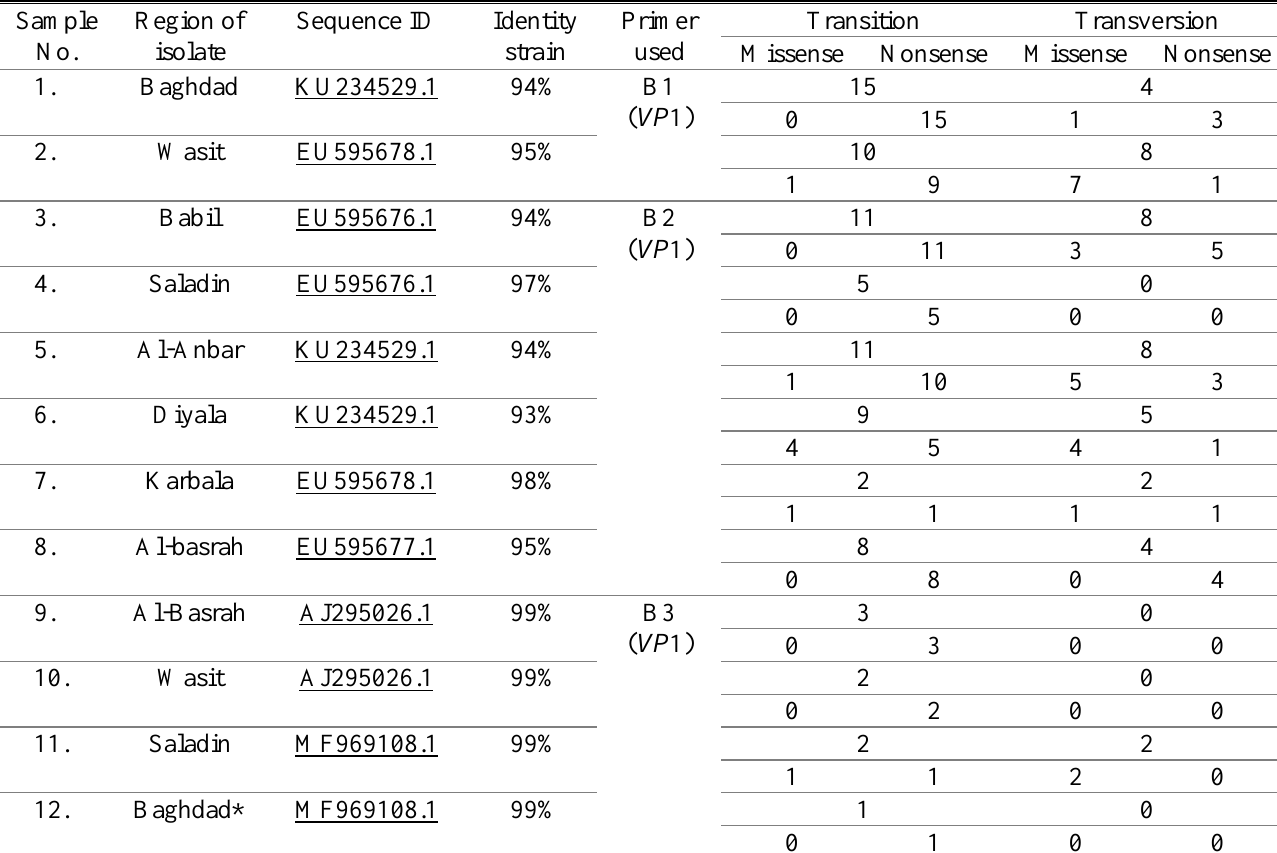
Table 3. Nucleotide changes of the sequences amplified from different regions of the VP 1gene on segment B Sample